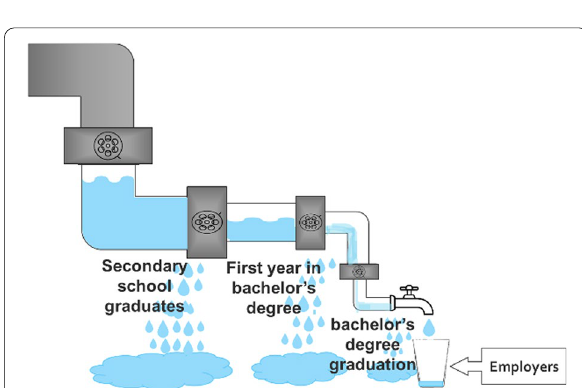
Fig. 11 Illustration of the leaking occurring in pathway #3 during significant periods in one’s